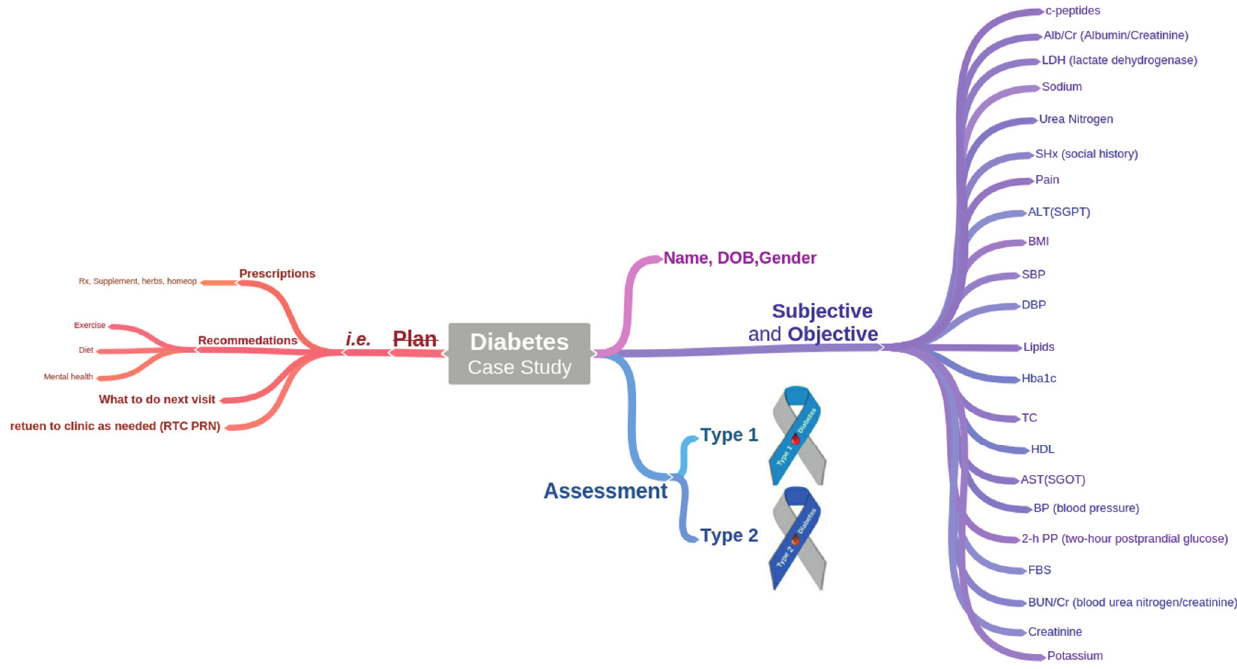
Figure 3. Distribution of diabetes patient’s observations in subjective, objective, assessment, and plan (SOAP)-based clinical